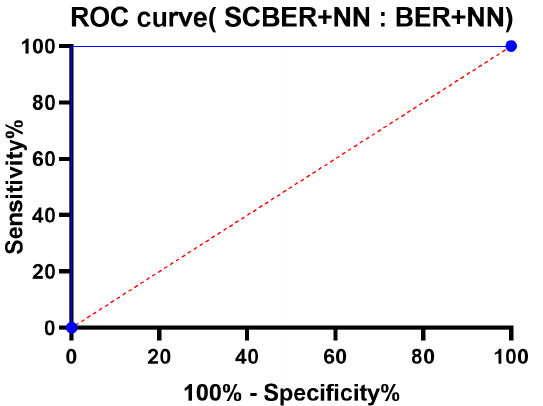
Figure 14. The ROC curve of the results achieved by the neural network optimized using SCBER in comparison with the results achieved by the neural network optimized using BER.